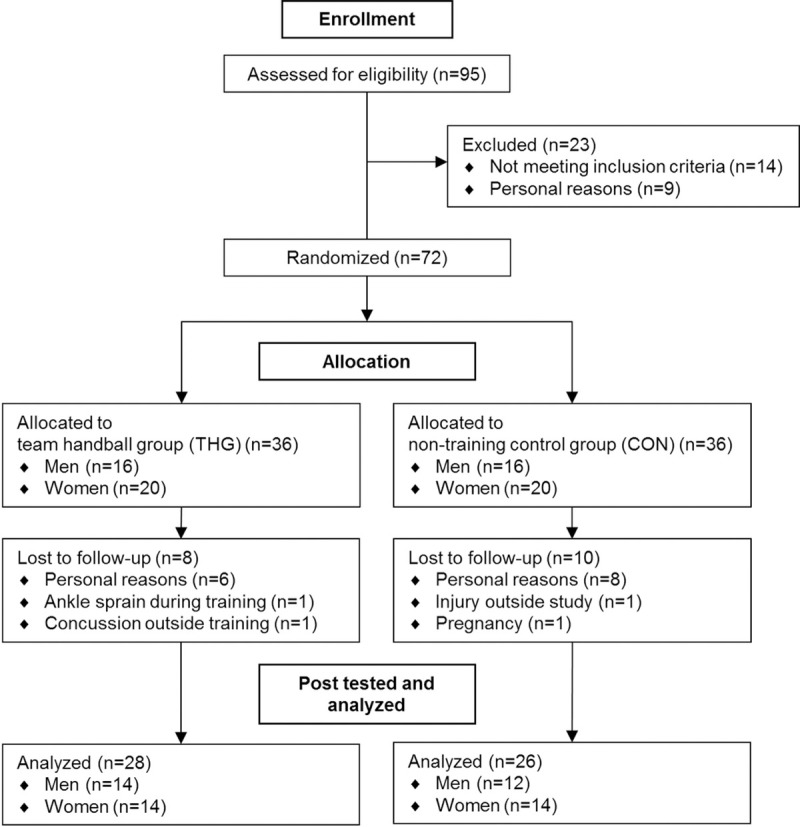
Participant recruitment.Flow diagram depicting the inclusion/exclusion of study participants in the initial phase of enrolment and during the subsequent phases of intervention allocation, post testing, and data analysis.